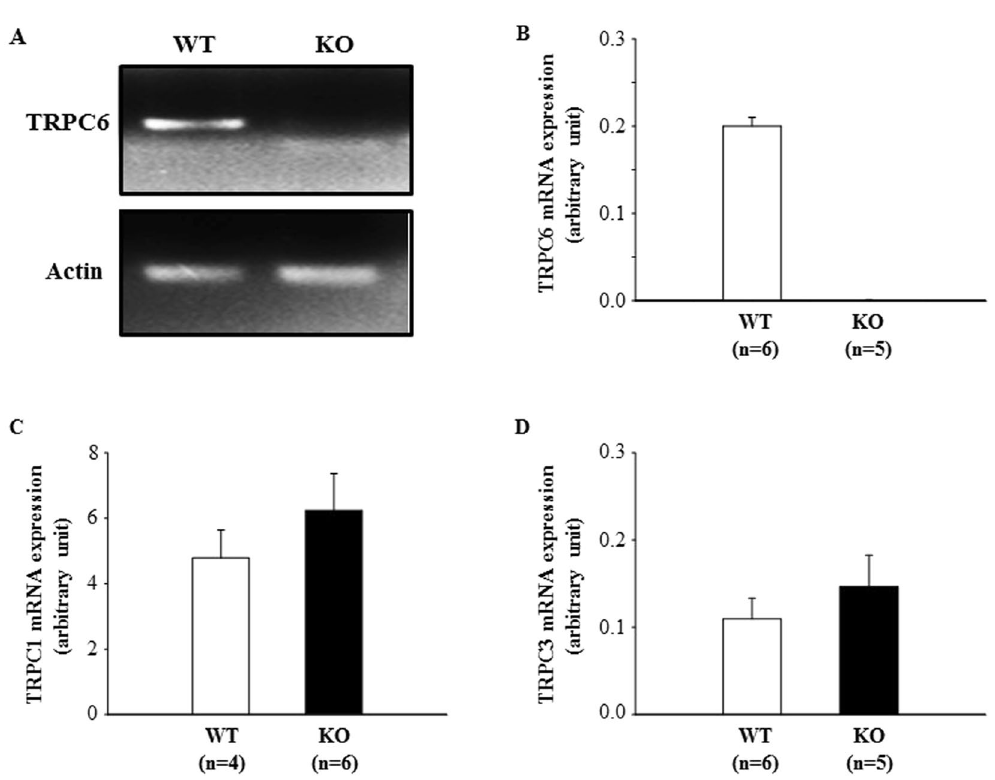
Figure 3. mRNA expression of TRPC1, TRPC3, and TRPC6 in the renal cortex of WT and KO mice. ( A ) A representative image or TRPC6 mRNA bands. An original and full-length gel showing TRPC1, TRPC3 and TRPC6 mRNA bands is presented in Fig. 1S of Supplementary Information. ( B–D ) Summary data of quantitative real time RT-PCR. Actin was used as a